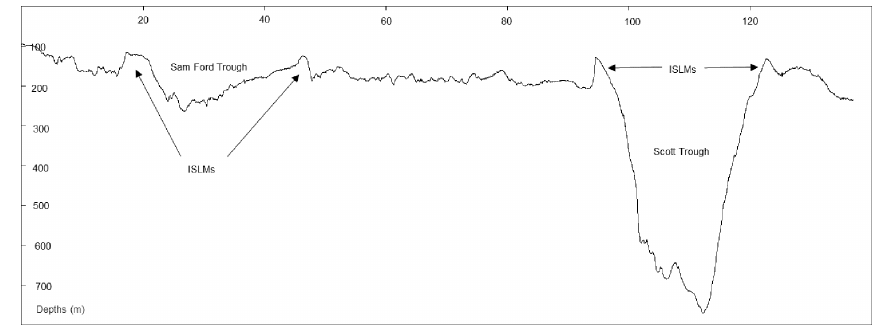
Figure 4. Bathymetric profile across the northeastern Baffin Island shelf showing Sam Ford and Scott troughs. The profile also shows the ice-stream lateral moraines on both sides of each trough.